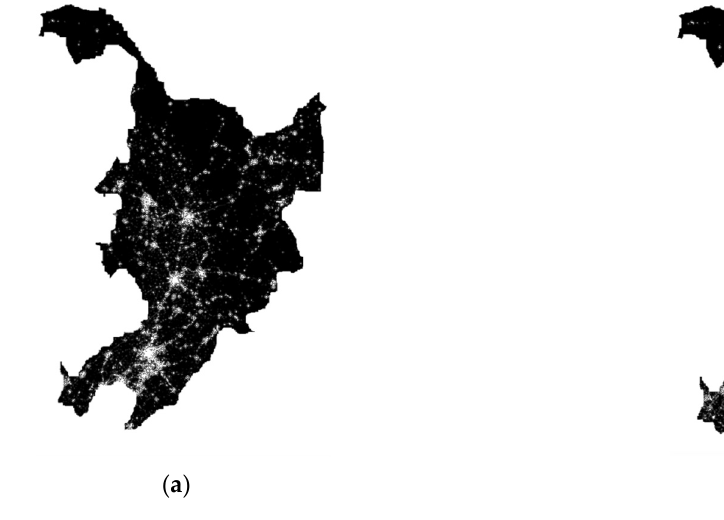
Figure 1. Nighttime lighting data in Northeast China in 2012 ( a ) and 2020 ( b ).